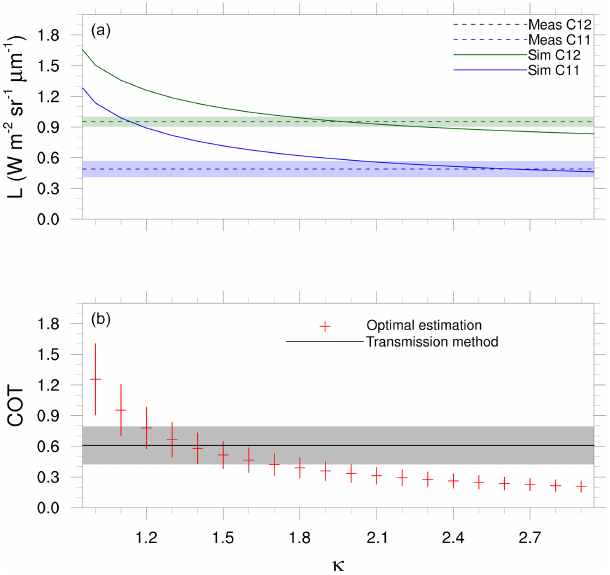
Figure 8. (a) Dependence of the simulated normalized radiances on a factor for the backscatter-to-extinction ratio ranging from 1.0 to 3.0 for the lidar profile measured on 30 November 2016 at 18:11UTC. The CLIMAT measurements of channels C11 and C12 are represented by the dashed lines; shaded zones indicate the mea- surement error. (b) Corresponding COT. The black line represents the COT derived from the transmission method and the shaded grey zone shows its error range.